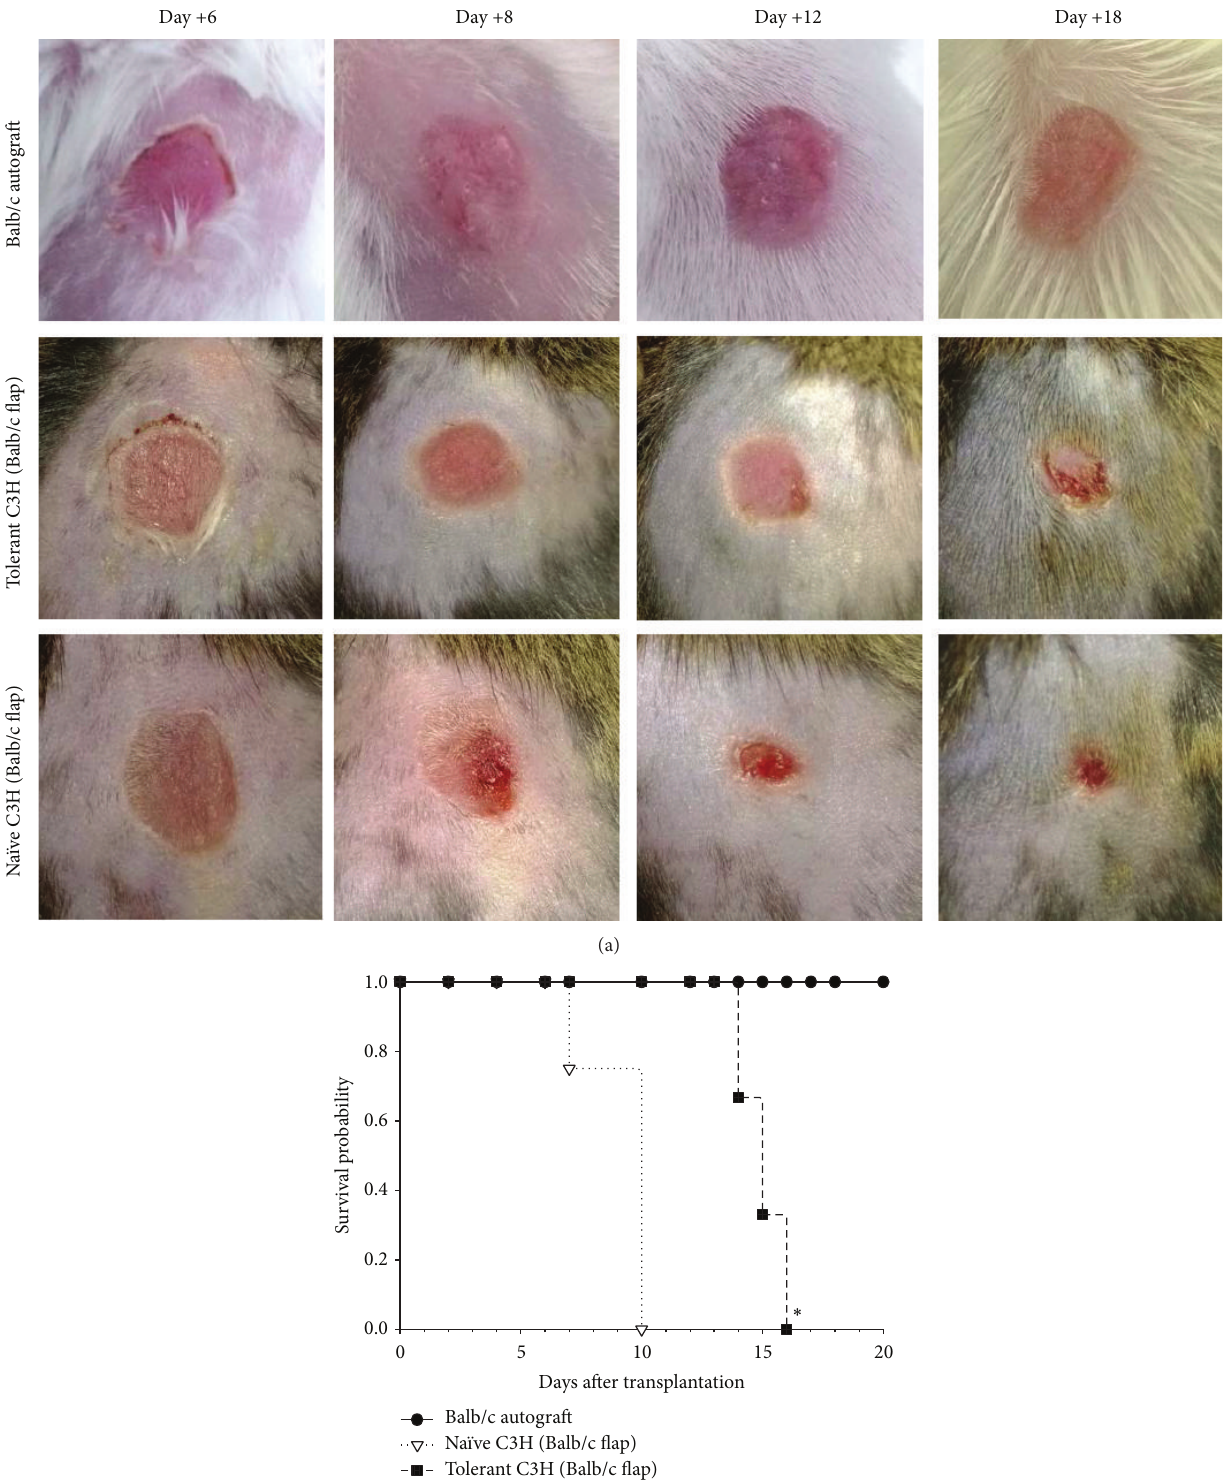
Figure 3: Tolerance induced by injection of UVB-iDCs prolongs the skin allograft survival. Six weeks after the last treatment for tolerance induction as described elsewhere, the tolerant and na¨ıve C3H mice were transplanted with Balb/c skin grafts as described in Section 2. The graft survival was monitored daily for 30 days. (a) The condition of a representative transplanted flap from each group is exhibited. (b) The graft survival of each group was shown. Six mice were included in each group. The survival data were analyzed by Log Rank test. ∗ 𝑃 < 0.05 (tolerant group versus na ¨ ıve